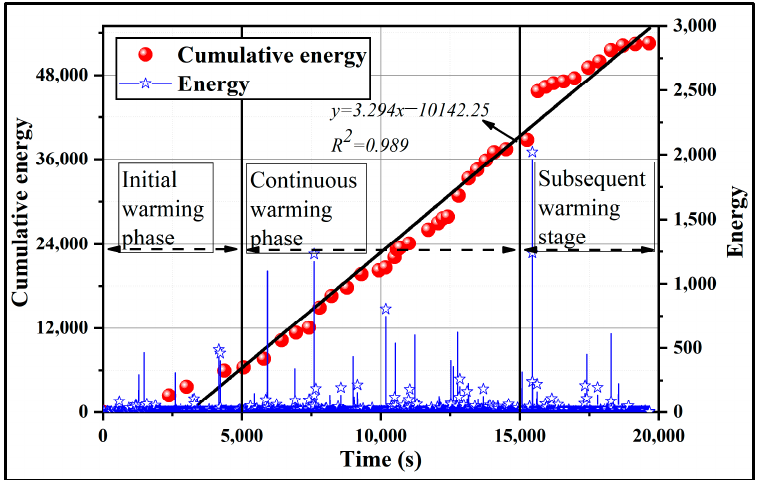
Figure 3. AE energy and cumulative energy map.